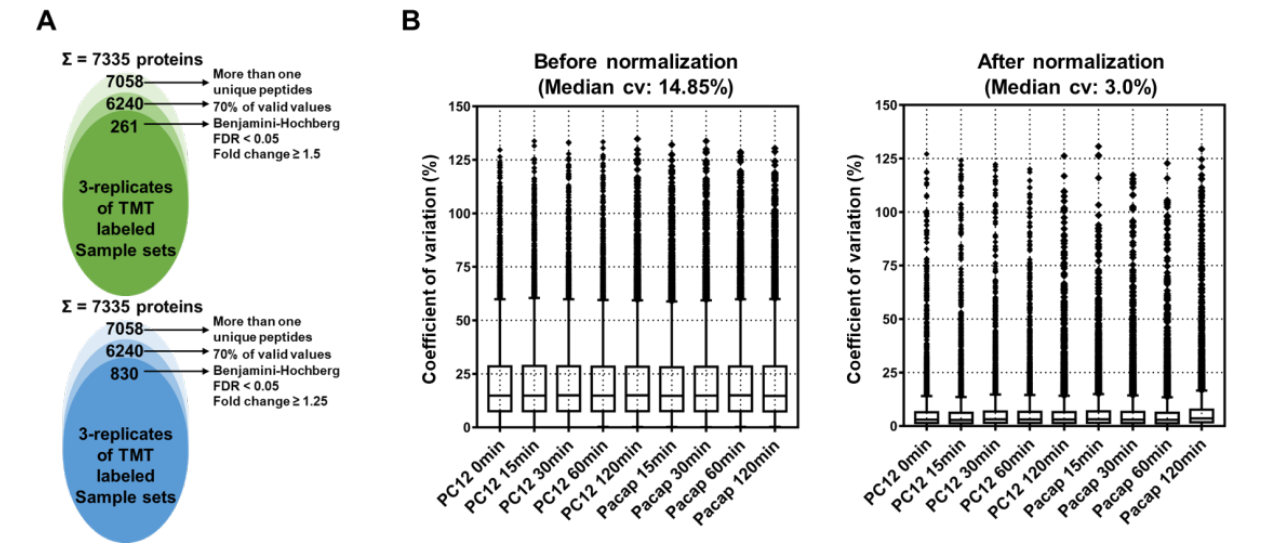
Figure 3. Label-free quantitative proteomic analysis of proteins extracted from PC12 cells. ( A ) Venn diagram showing the distribution of the total identified and significantly modulated proteins during different stages of analysis. The upper panel shows number of significant proteins with a fold change cut off value of ≥1.5 , while the lower panel shows significant proteins with a fold change cutoff value of ≥1.25. ( B ) Box plots showing CV values before and after the application of IRS normalization. To examine the correlation and variations among sample sets and the reproducibility of different replicates of the same sample, multi-scatter plot and principal component analyses (PCA) were performed using Perseus software. The Pearson’s correlation coefficient values of different samples were in a range of 0.991 to 0.998, indicating a high degree of correlation